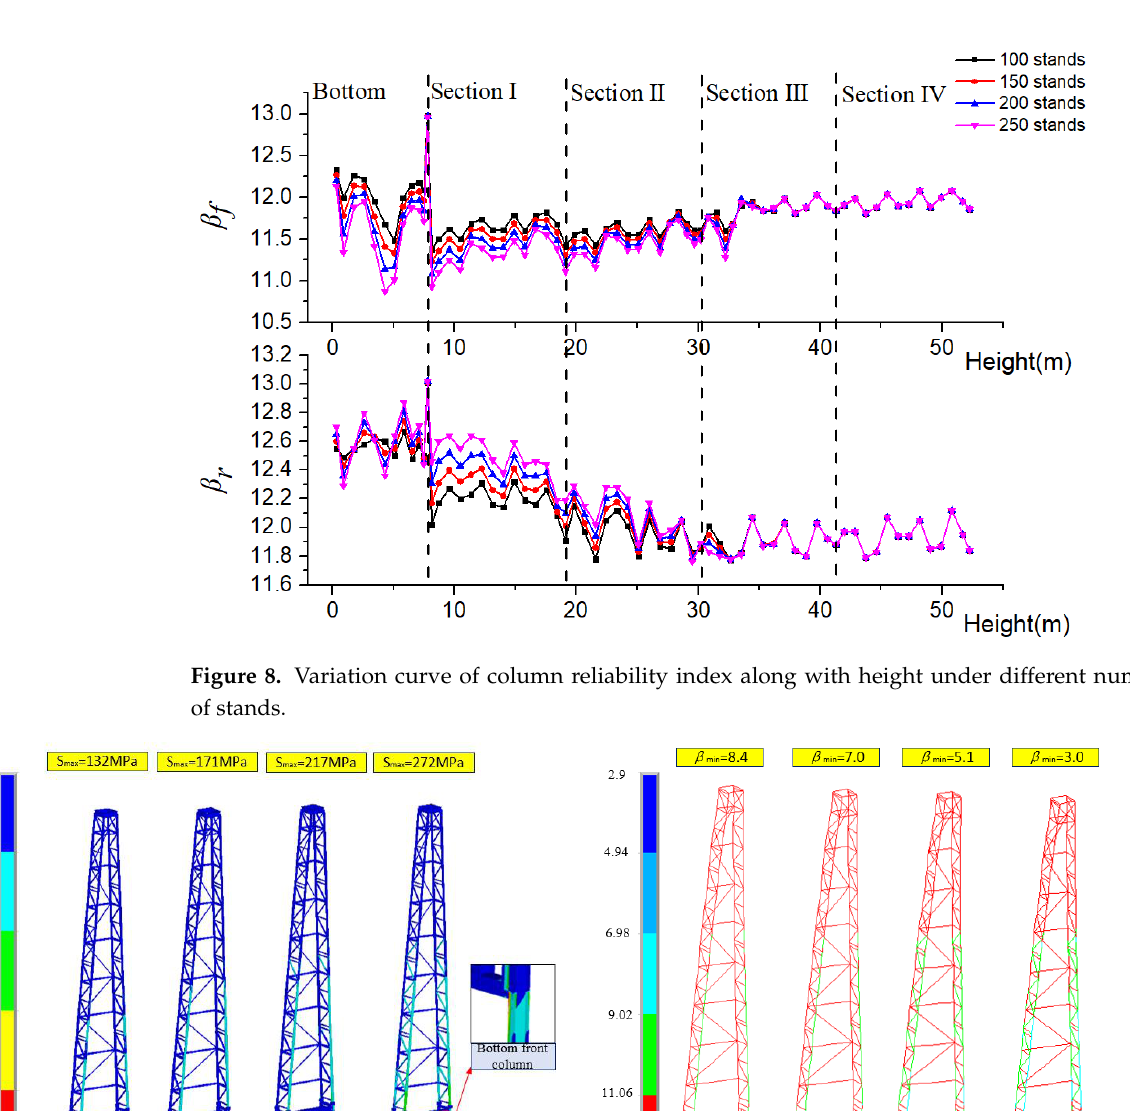
Figure 10. Variation curve of column reliability index along with height under different wind speeds. 5. Discussion 5.1. The Contribution of Each Load to Strength and Reliability